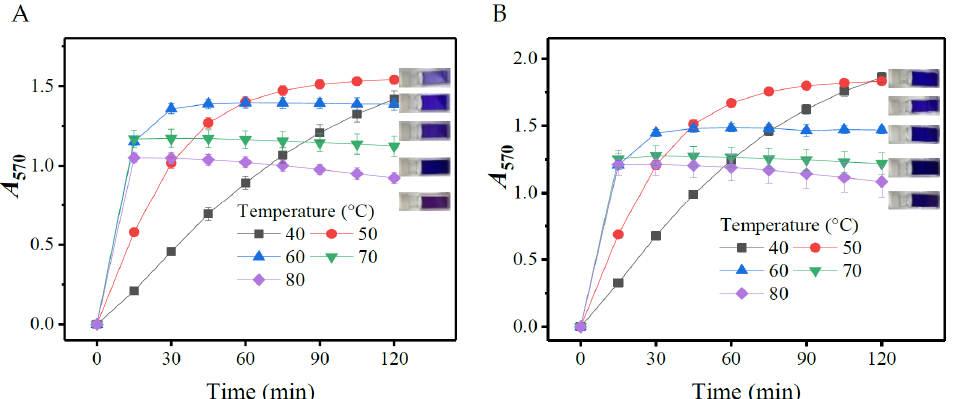
Figure 4. Effects of temperature on color yield of gamma-aminobutyric acid ( A ) and L-glutamic acid ( B ). The rightmost part of each diagram shows the reacted mixtures under different temperatures (from top to bottom: 40, 50, 60, 70, and 80 °C). A 570 : absorbance at 570 nm.